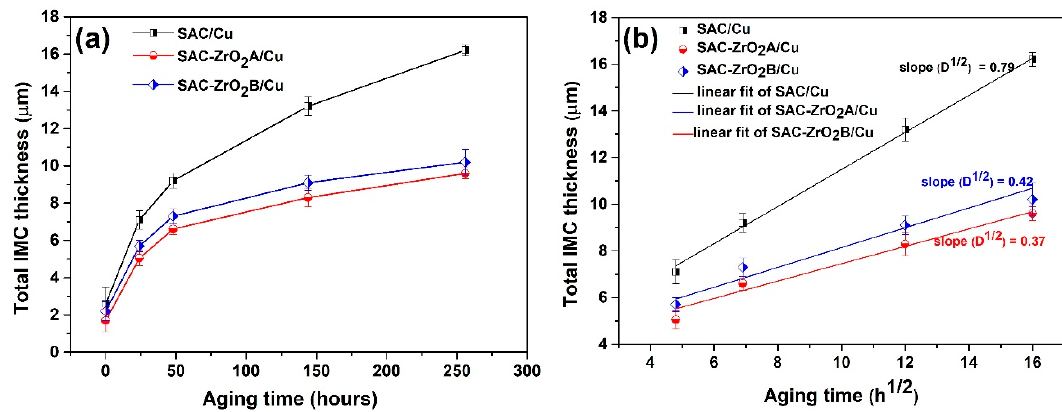
Figure 6. Plots of Total Cu-Sn IMC thickness versus ( a ) aging time and ( b ) square root of the aging time at 175 ℃ isothermal aging condition .